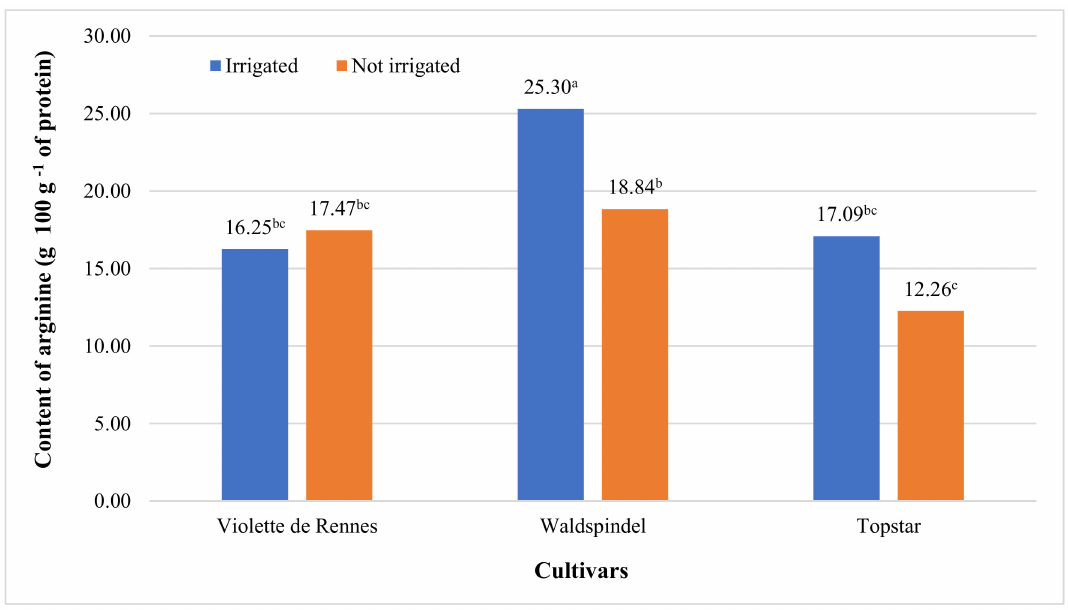
Figure 6. The e ff ect of irrigation on the arginine content of tubers in the analyzed Jerusalem artichoke cultivars. Means with the same letters do not di ff er significantly at p ≤ 0.05 in Tukey’s test. The absence of letters denotes non-significant main e ff